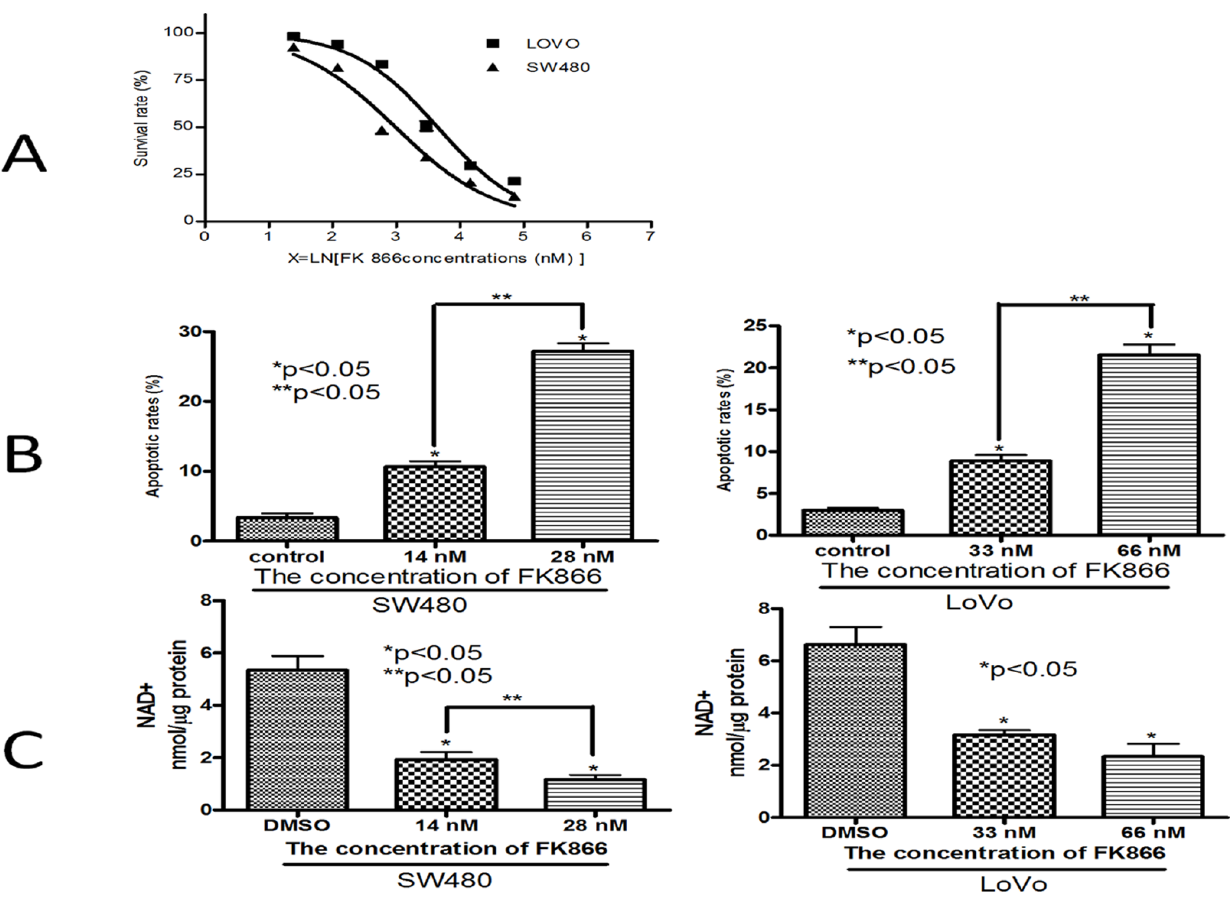
Figure 1. Nampt inhibitor FK866 reduced cell survival rate and the NAD level in a dose-dependent manner in SW480 and LoVo cell lines. A. Cells were treated with different concentrations of FK866 for 72 h and then evaluated by using Cell Counting Kit-8. The IC 50 values were calculated. Each assay was repeated at least 3 times. B. The quantification of apoptotic cells induced by FK866 was confirmed by flow cytometry analysis. The sub-G1 contents were designated apoptotic cells. *: versus negative control group; **: compared with 2 treatment groups. C. NAD levels in colorectal cancer cells were measured after exposure to FK866. Each vertical bar represents the mean 6 SD of triplicate determinations. For comparison of 2 groups, a two-tailed, unpaired t-test was used.